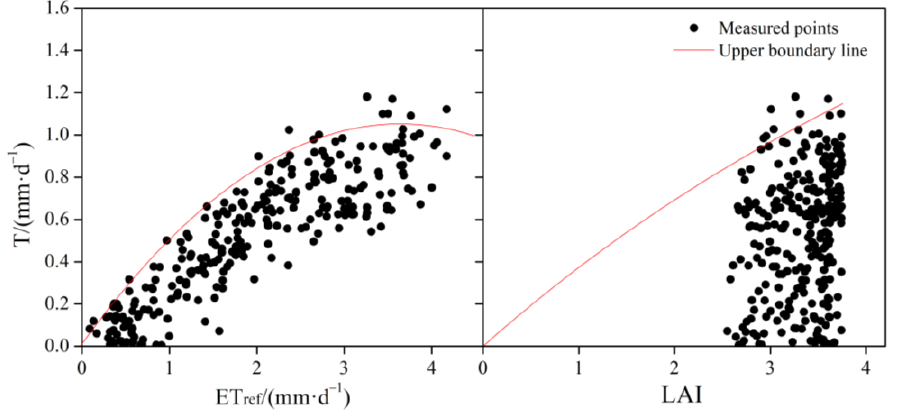
Figure 3. Response of T to ET ref and LAI from 2017 to 2019. Table 3. The response relationship of T to ET ref , LAI, and RSWC in different soil layers and their